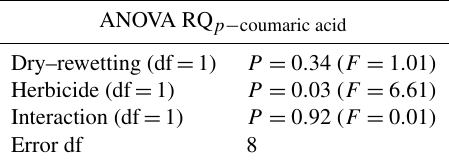
Table 1. Two-way ANOVA of respiratory quotient (RQ) values. The P values indicated for the main effects of herbicide and of dry– rewetting disturbances correspond to the model without interaction as no significance ( P > 0 . 05) was observed for this term. df: de- grees of